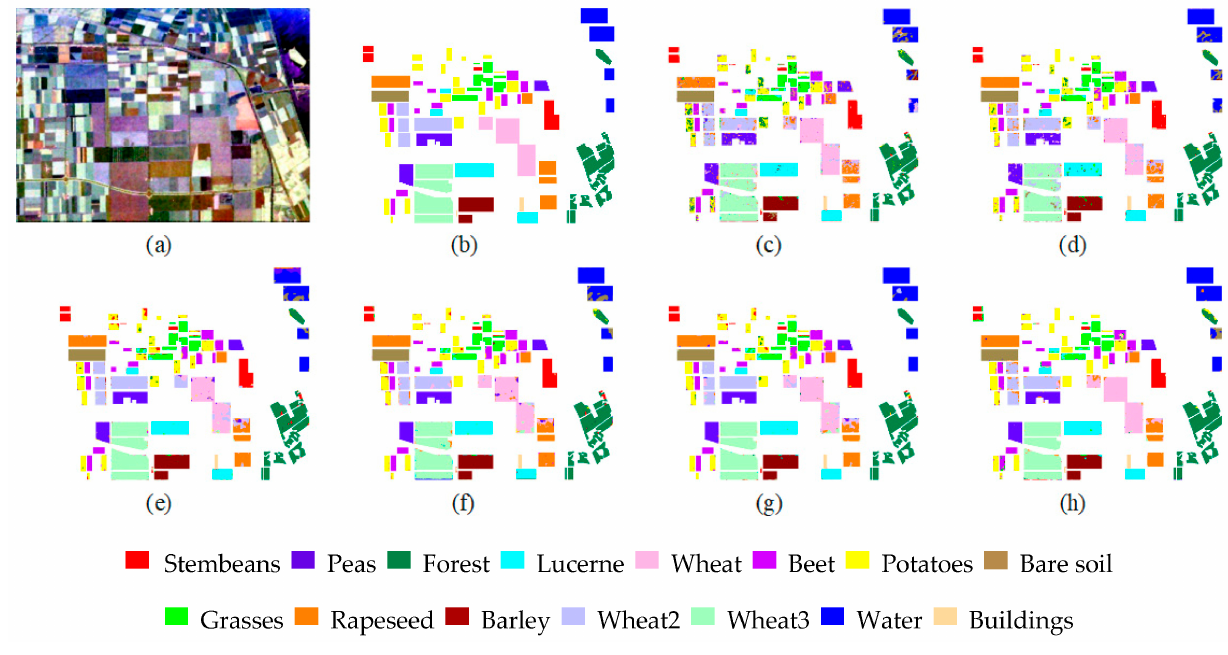
Figure 12. Classification results in the Flevoland I area. ( a ) Pauli image. ( b ) Ground-truth image. ( c ) RN. ( d ) RN-SWANet. ( e ) RRN. ( f ) RRN-SWANet. ( g ) 3D-RRN. ( h ) 3D-ARRN. Table 3. The classification accuracy (%) of different methods with 7 labeled samples per class on Flevoland